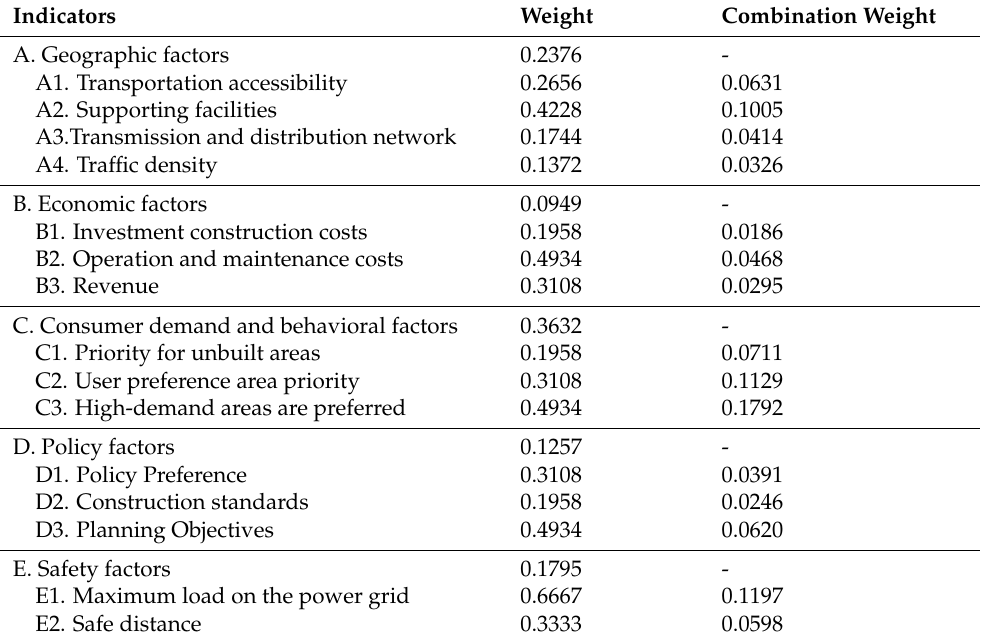
Table 4. Index weight table.